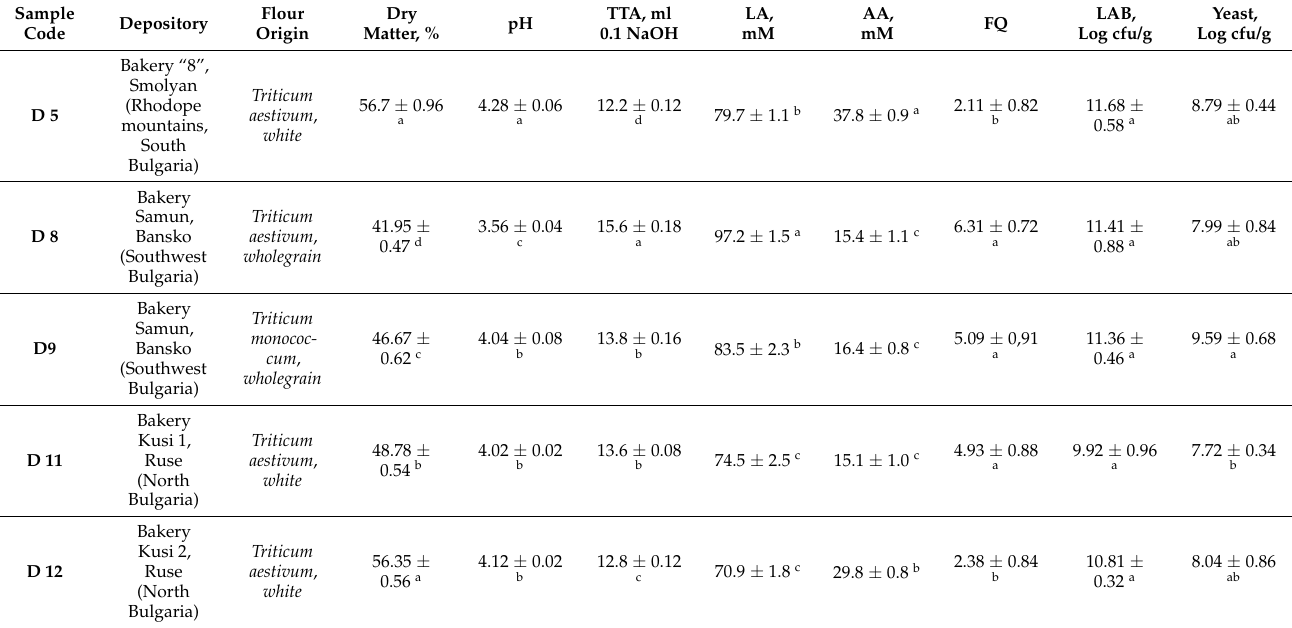
Table 1. Physicochemical, biochemical, and microbiological characteristics of Bulgarian sourdoughs (no baker’s yeast used). Mean values with a different letter in superscript within the same column differ significantly ( p <